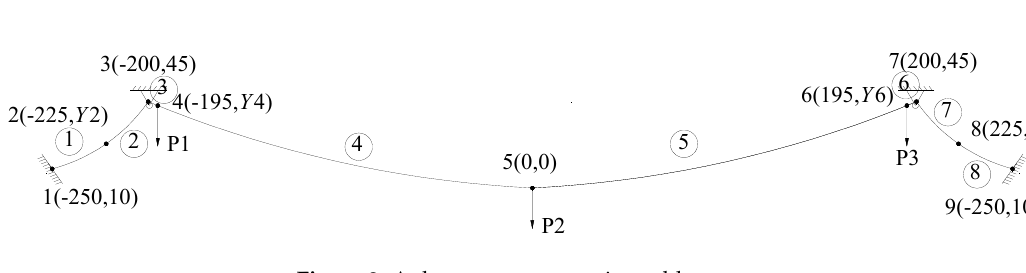
Figure 2. A three-span suspension cable system.